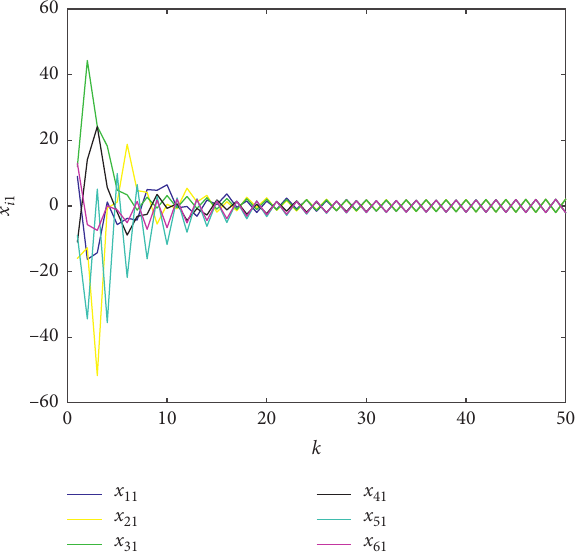
, i � 1 , 2 , ... , 6, under state feedback protocol. i 2